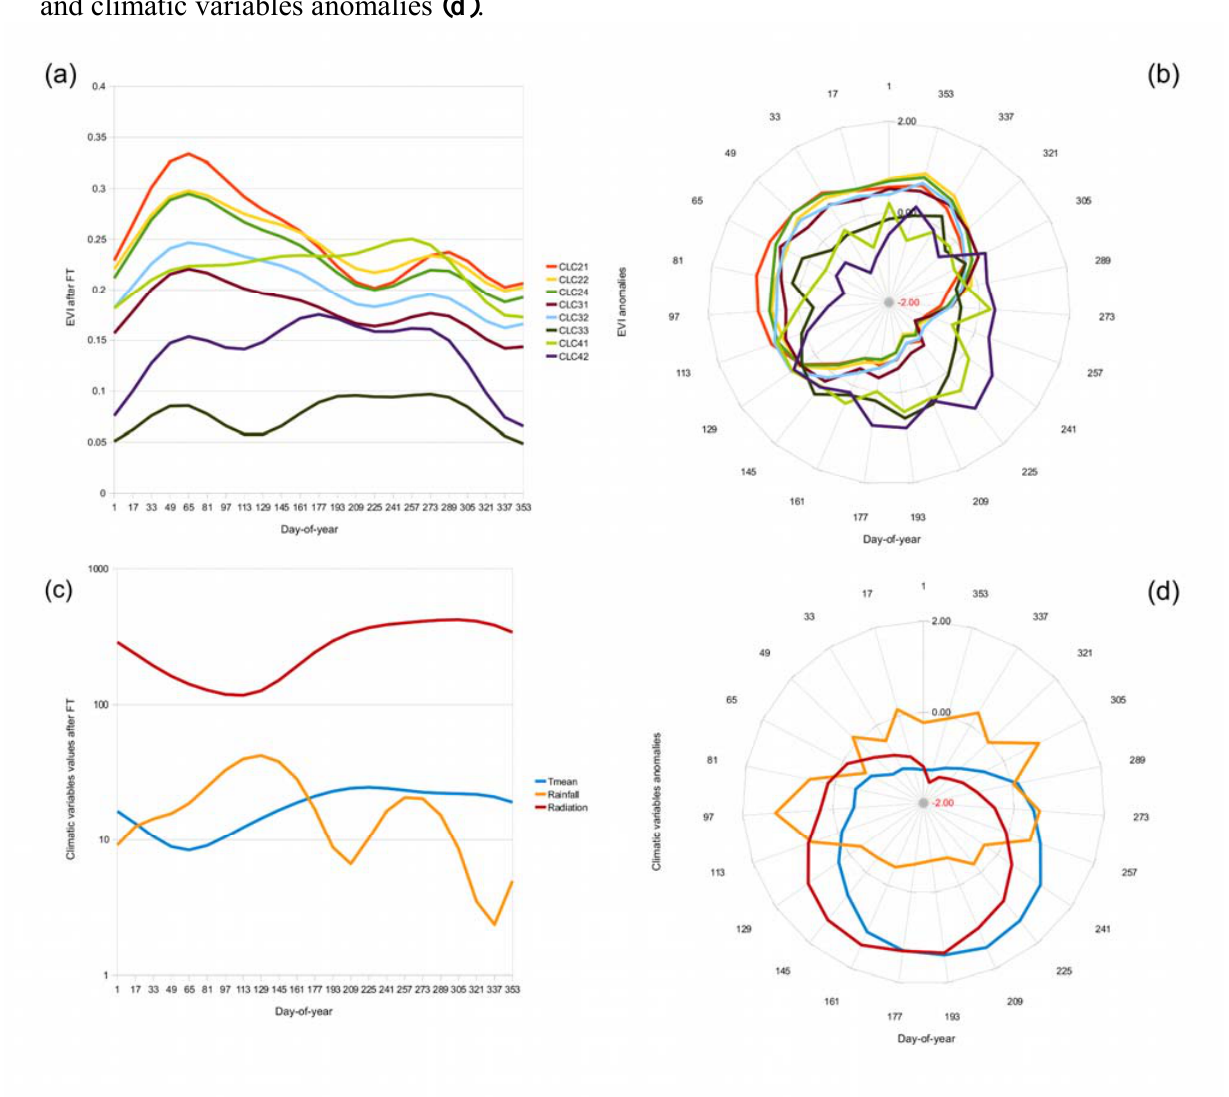
Figure 2. Time series reconstruction with the first three harmonic terms for EVI time series (a) and climatic variables (c) in the test areas. Polar plots show EVI anomalies (b) and climatic variables anomalies (d)